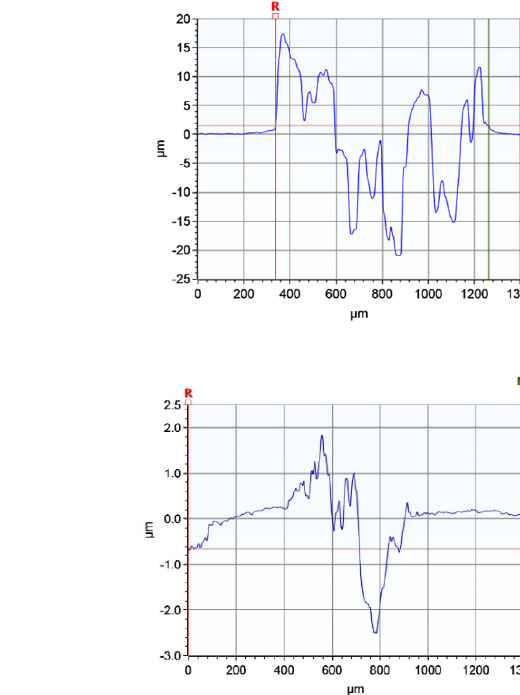
Figure 18. SEM images of the wear track and linear analysis of changes in chemical composition of ( a ) copper and ( b ) copper surface layer with Cr50WC50.